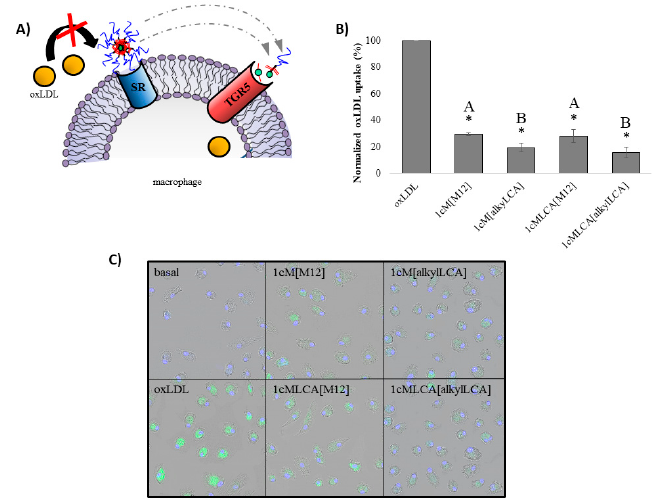
Figure 4. AScM NPs inhibit oxLDL uptake in macrophages (schematic, A ). All NPs lower oxLDL uptake in hMDMs compared to basal controls as measured via flow cytometry and indicated with (*) ( B ) Core chemistry has a significant impact on oxLDL uptake inhibition levels, but shell chemistry does not significantly alter efficacy as indicated by letters. Bars with different letters represent statistical differences. Confocal microscopy images of oxLDL uptake by hMDMS 24 h after treatment with AScM NPs cell nuclei (DAPI, blue), and DiO labeled oxLDL (DiO, green) 40 × magnification ( C